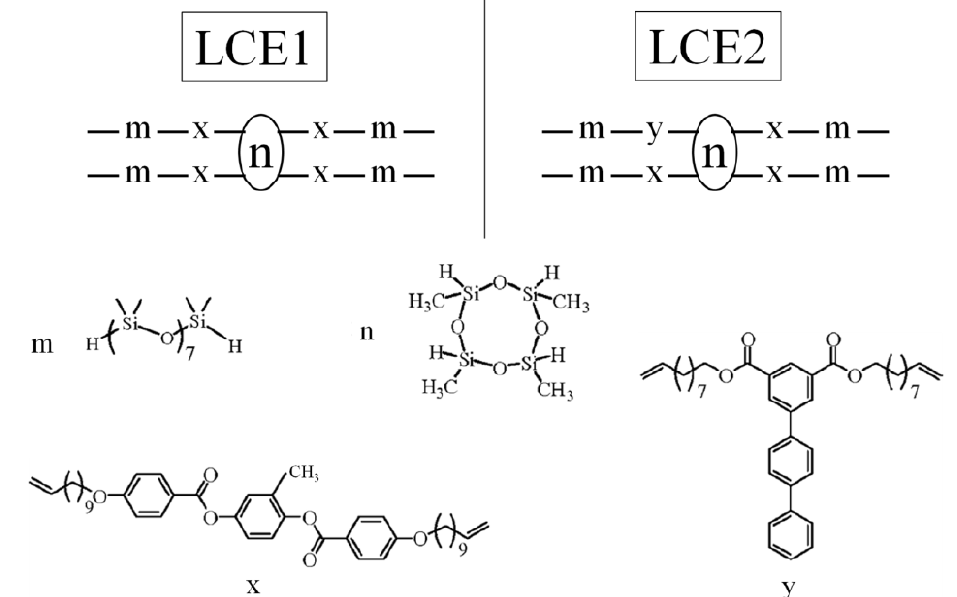
Figure 5. Schematic representation of elastomers LCE1 and LCE2: Here, “ x ” is the mesogen; “ y ” is the TR3 incorporated into the main chain of LCE2, “ m ” is siloxane spacer, “ n ” is a octasiloxane crosslinker. LCE1 has only the mesogens incorporated at the “end-on” positions where as many as four chains could attach to the crosslinker. In LCE2, 20% of the “ x ”-blocks are replaced by “ y ” blocks. Adapted from reference